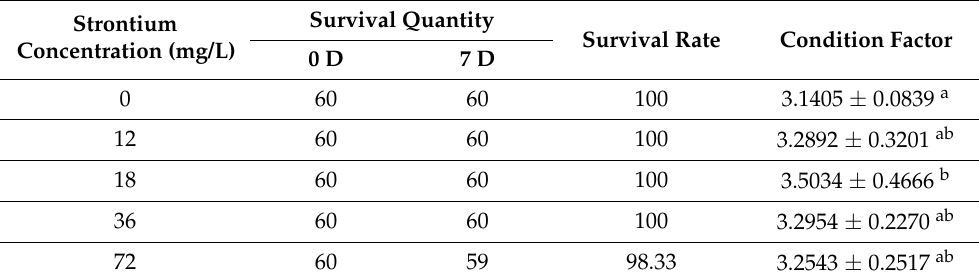
Table 1. The growth and survival of 60 T. obscurus during immersion.